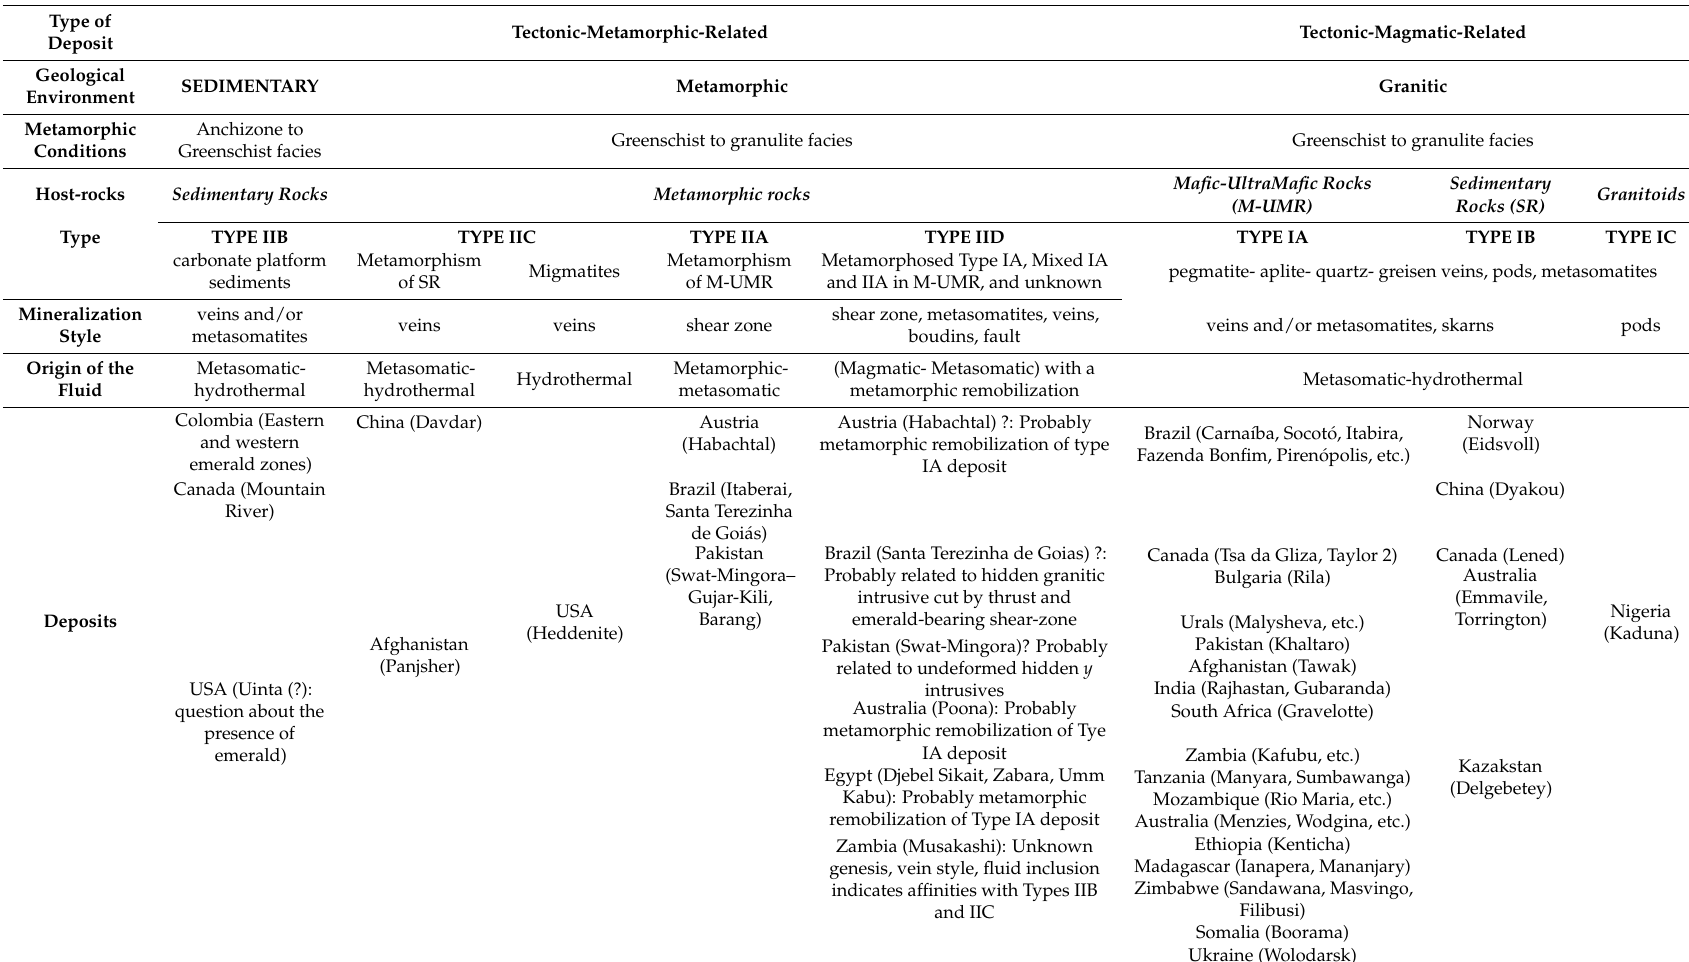
Table 2. New typological classification of the emerald occurrences and deposits